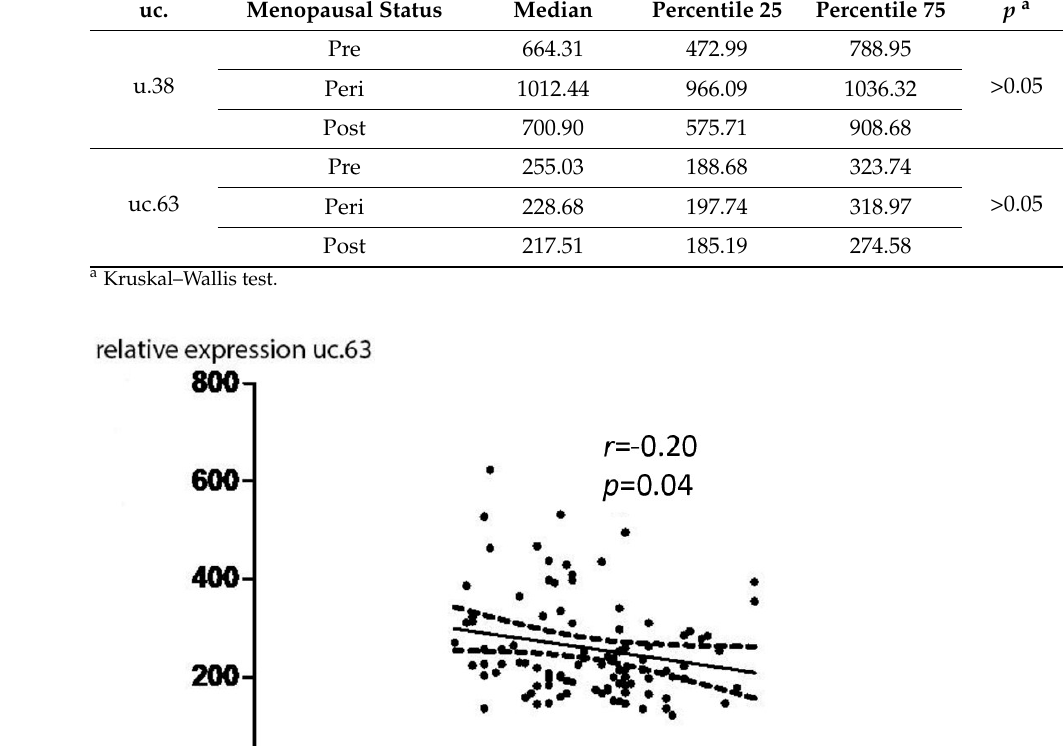
Table 6. Expression of uc.38 and uc.63 in breast cancer patients in relation to menopausal status. uc.